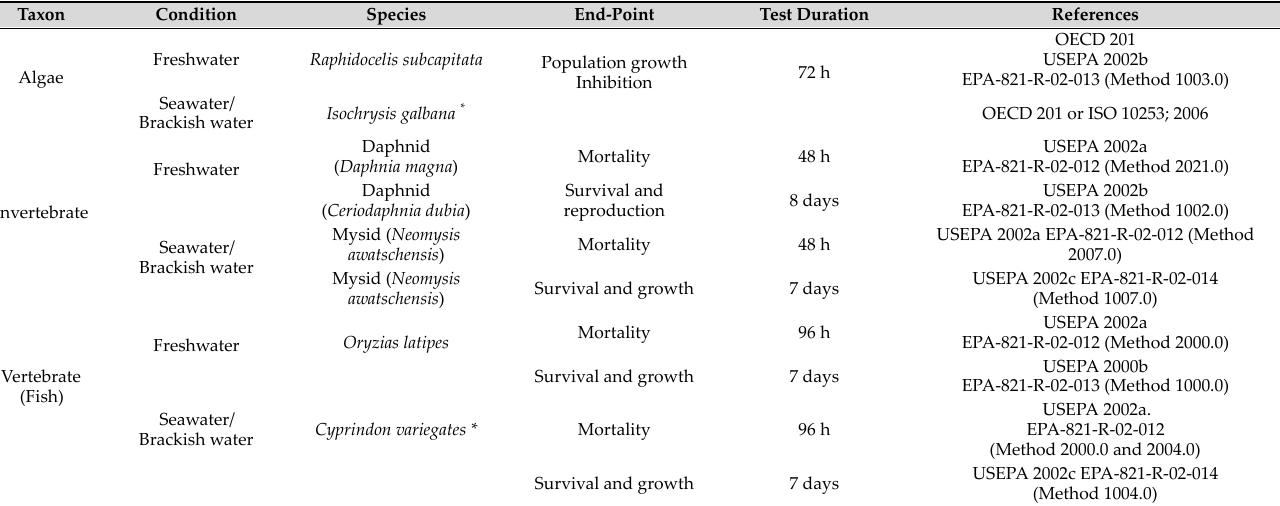
Table 3. Test species and test references used for whole effluent toxicity (WET)